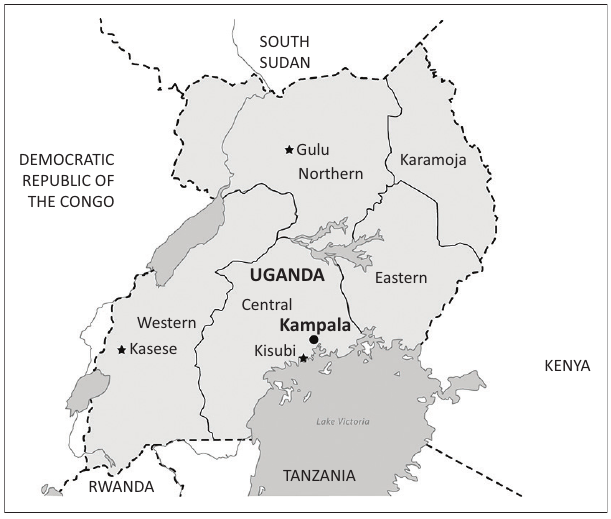
FIGURE 1: The three areas in Uganda from which participants were recruited: Kisubi in the Central region (bottom right), Kasese in the Eastern region (left) and Gulu in the Northern region (top). TABLE 3: Summarised overview of geography, wheelchair services and community-based rehabilitation programmes per study setting.